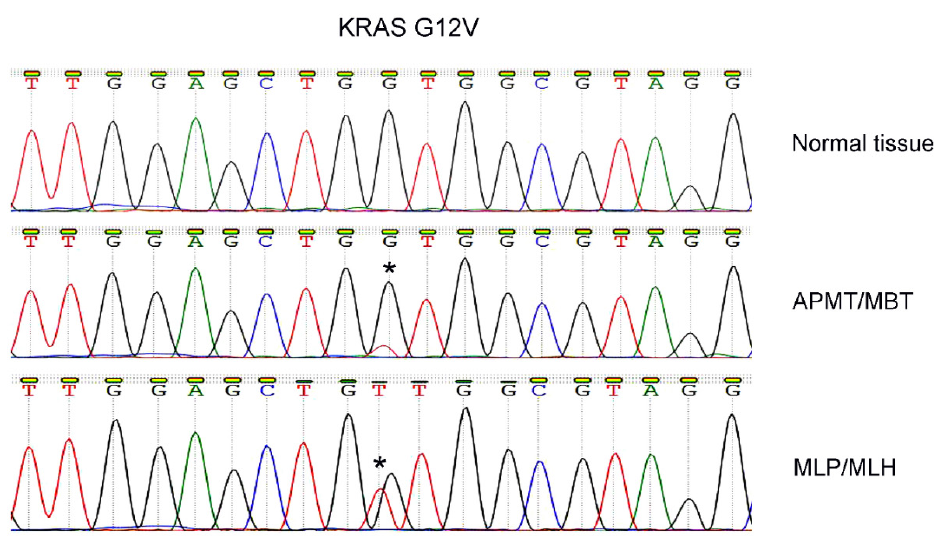
Figure 3. Molecular study/Sanger sequencing showed that the KRAS G12V mutation was present in both atypical proliferative mucinous tumor/mucinous borderline tumor/(APMT/MBT) and mesonephric-like proliferation/mesonephric-like hyperplasia (MLP/MLH), indicating their clonal origin. Star (*) indicates mutational site.